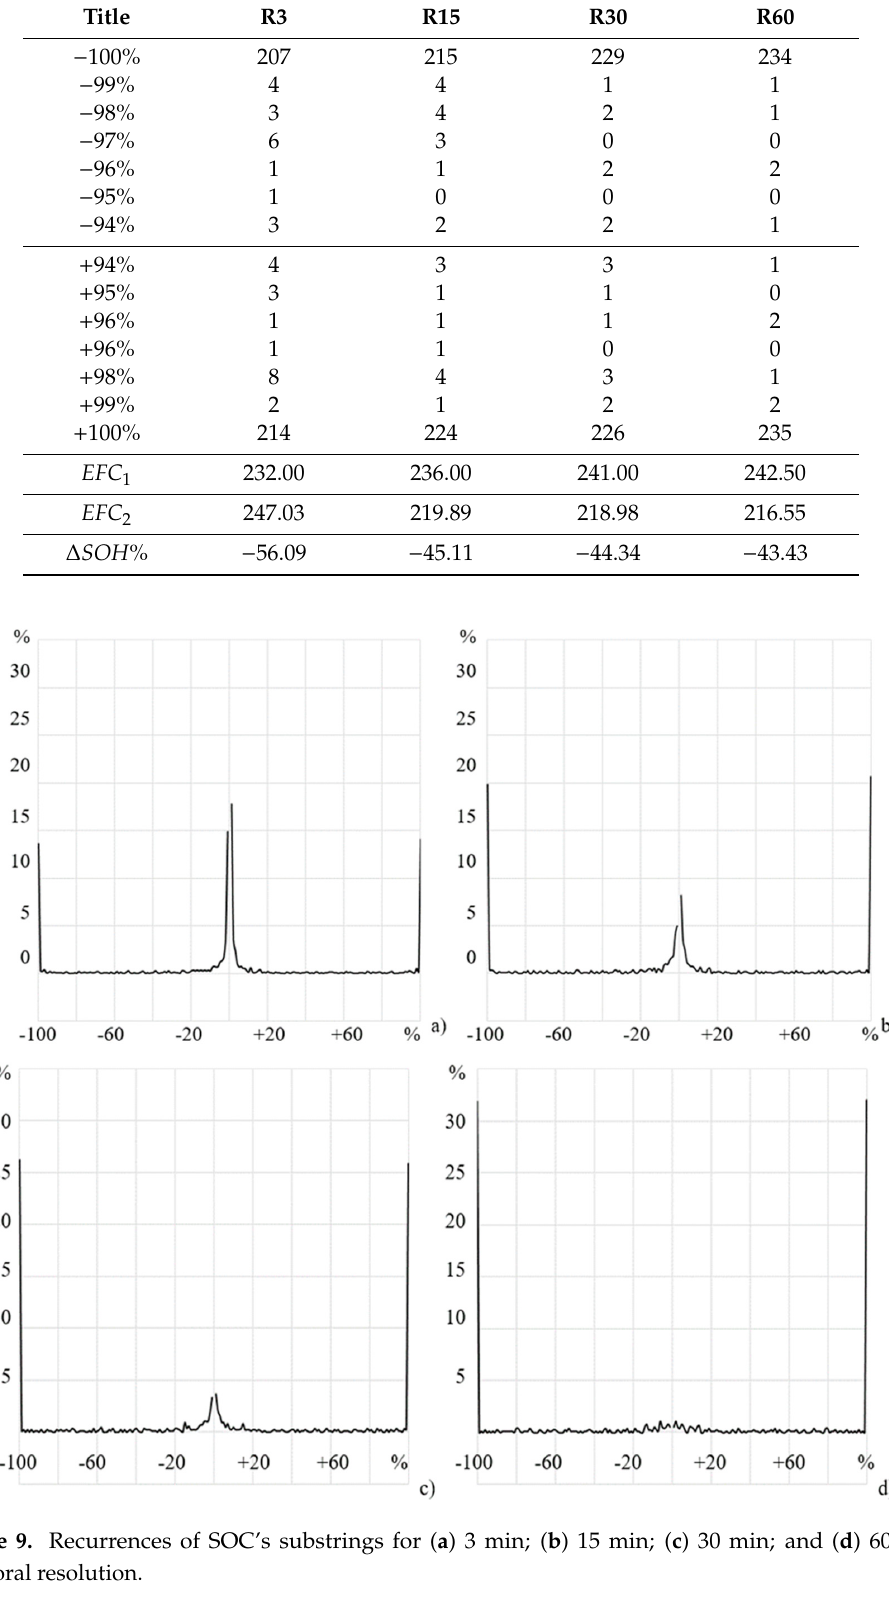
Figure 9. Recurrences of SOC’s substrings for ( a ) 3 min; ( b ) 15 min; ( c ) 30 min; and ( d ) 60 min temporal resolution.